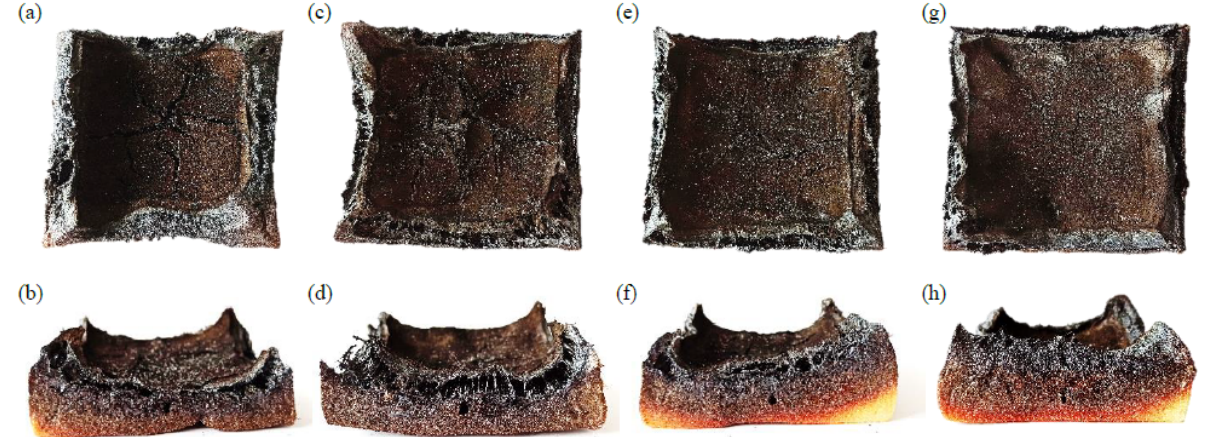
Figure 15. Polyurethane foams residues after the combustion process: ( a , b ) PUR_REF, ( c , d ) PUR_AS_C_1, ( e , f ) PUR_AS_C_2, and ( g , h ) PUR_AS_C_5.